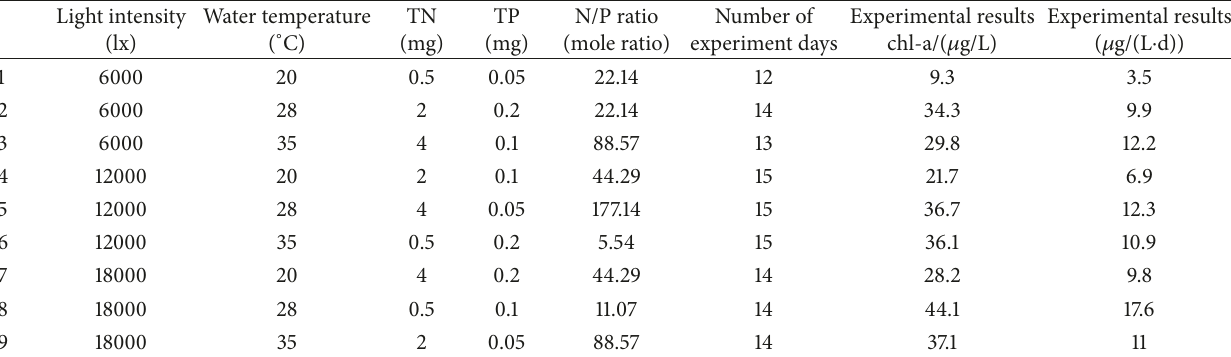
Table 3: Data summary table of orthogonal experiment